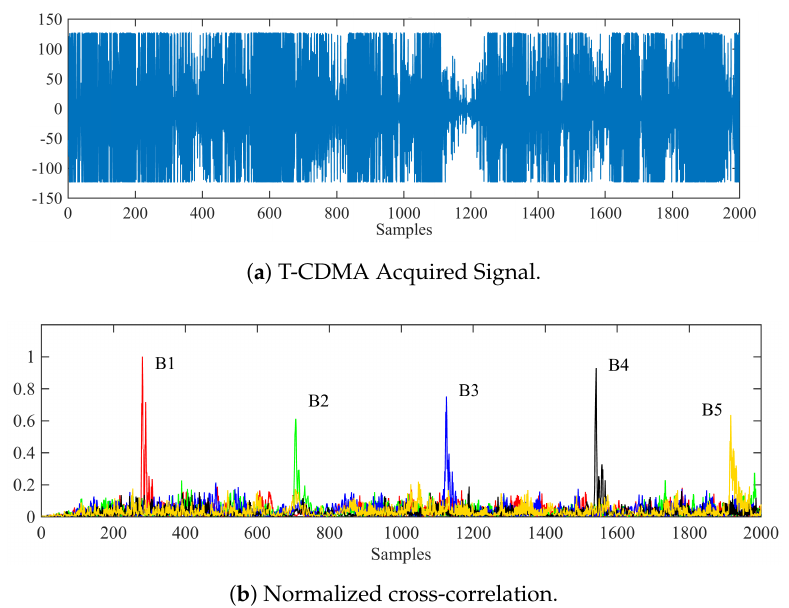
Figure 4. ( a ) Acquired signal for the receiver and ( b ) normalized cross-correlation with a set of five Kasami codes assigned to the